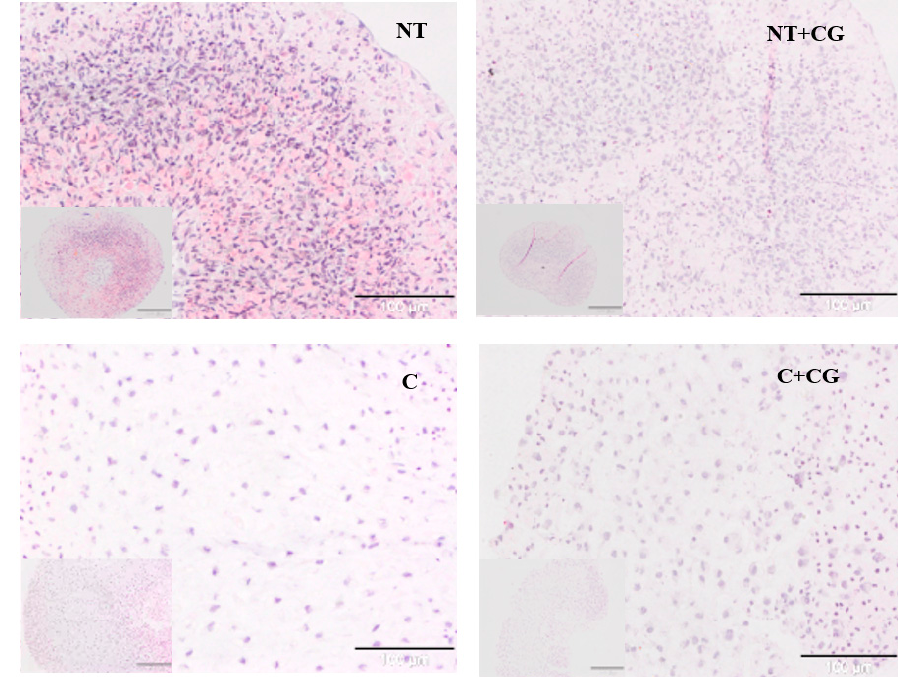
Figure 3. Human chondrocytes cultured under different conditions: NT, not treated; NT+CG, CG 1 mg/mL added; C, chondrogenic medium added; C+CG, chondrogenic medium, and CG 1 mg/mL added. Hematoxylin and eosin staining; bars of small pictures = 100 µm; bars of large pictures =200 µm. Table 1. Bern Scores of human chondrocytes.